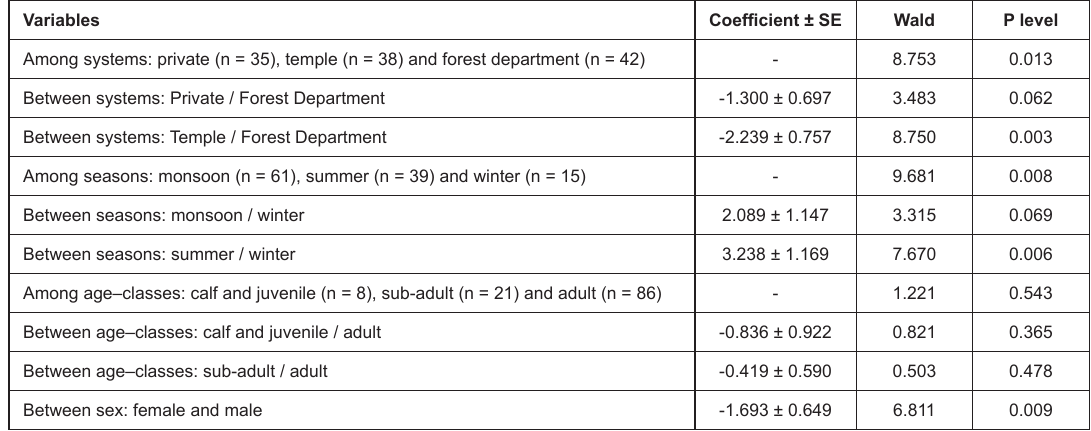
Table 2. Results of logistic regression analyses carried out to test the significance of intestinal parasite prevalence among systems, seasons, age–classes and between